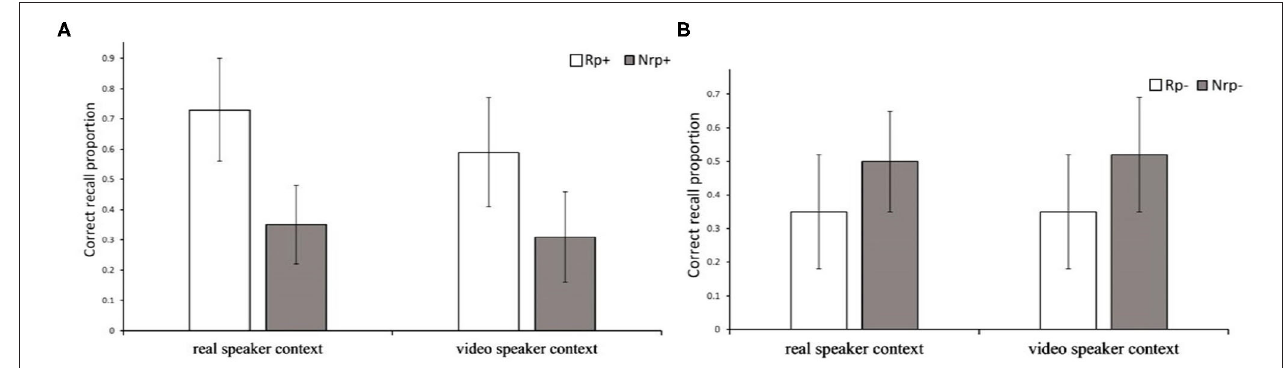
FIGURE 1 | Correct recall rate of RP + , NRP + , RP–, and NRP– items of listeners at different levels of social interaction. (A) Recall performance of listeners’ Rp + and Nrp + items in the final test under different levels of social interaction. Rp + , practiced words from practiced categories; Nrp + , words from unpracticed categories used as baseline for Rp + words. Error bars indicate standard error of the mean. (B) Recall performance of listeners’ Rp − and Nrp − items in the final test under different levels of social interaction. Rp − , unpracticed words from practiced categories; Nrp − , words from unpracticed categories used as baseline for Rp − words. Error bars indicate standard error of the mean.